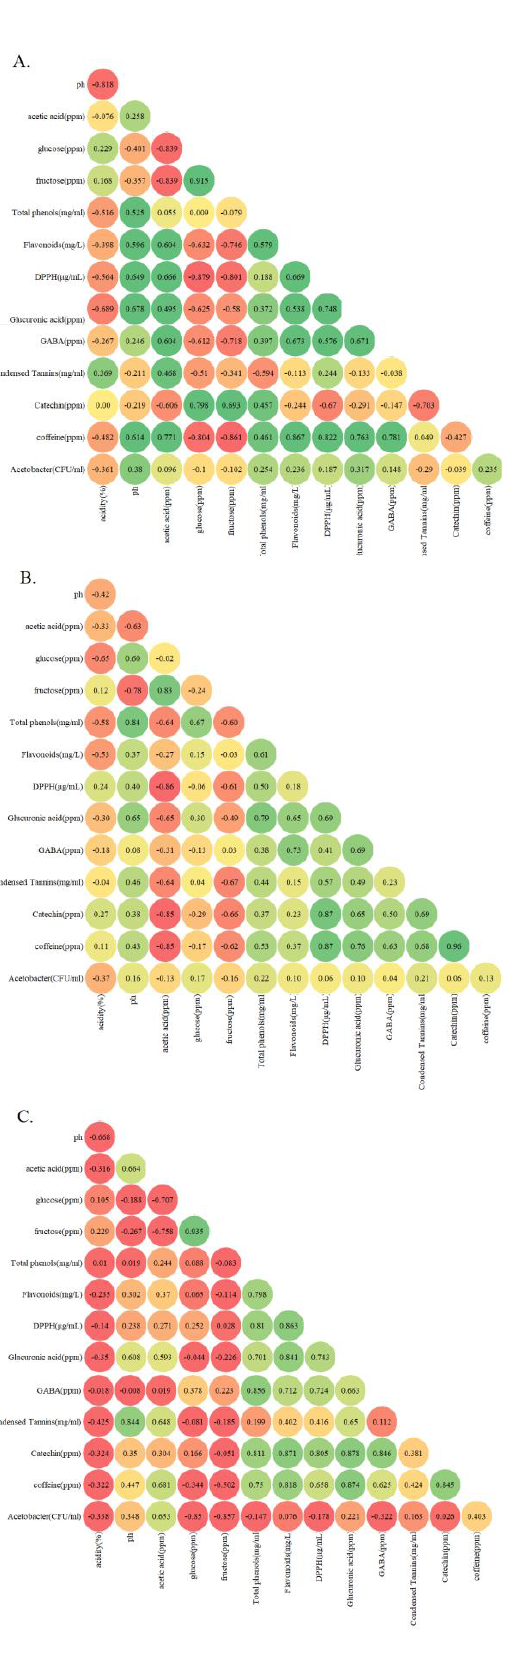
Figure 5. Pearson correlation analysis between the nutritional and bio-functional compounds